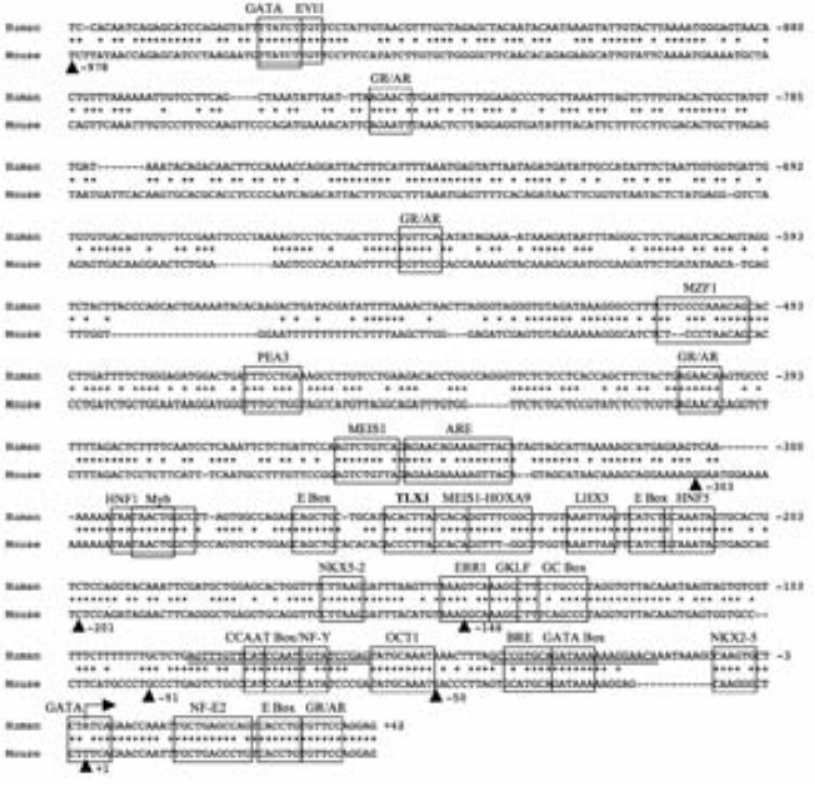
Figure 1. Nucleotide sequence alignment of the human and mouse ALDH1A1 promoters. Conserved nucleotides are marked with an asterisk. Numbers at right indicate nucleotide positions of the human sequence relative to the transcriptional start site (bent arrow). Potential regulatory elements, including a conserved TLX1 site at -257, are boxed and labeled. Solid triangles with numbers demarcate the 5’ ends of the promoter deletion con- structs used in the luciferase reporter assays. The two regions used for gel shift analysis are underlined at -85 to -60 and -42 to -19. BRE, TFIIB recognition